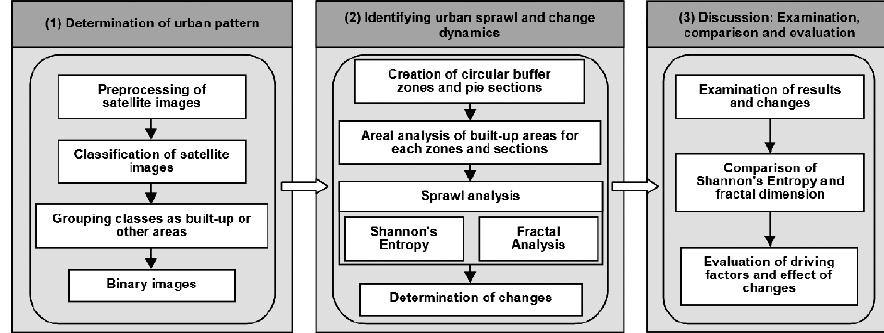
Fig. 2. Flow chart showing the main steps of the study